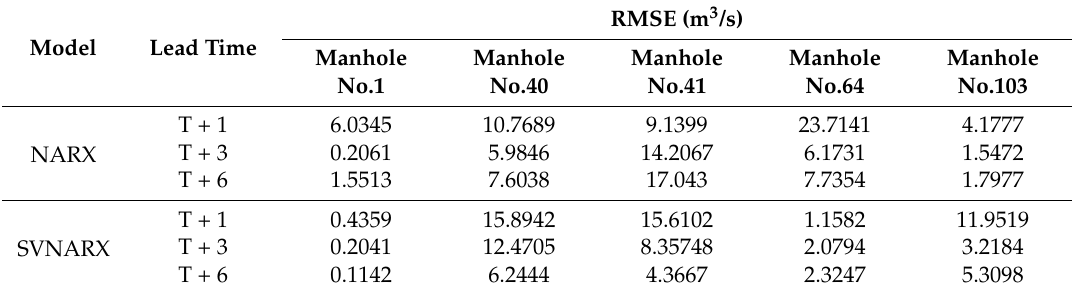
Table 3. RMSE (Root Mean Square Error) value at each manhole.